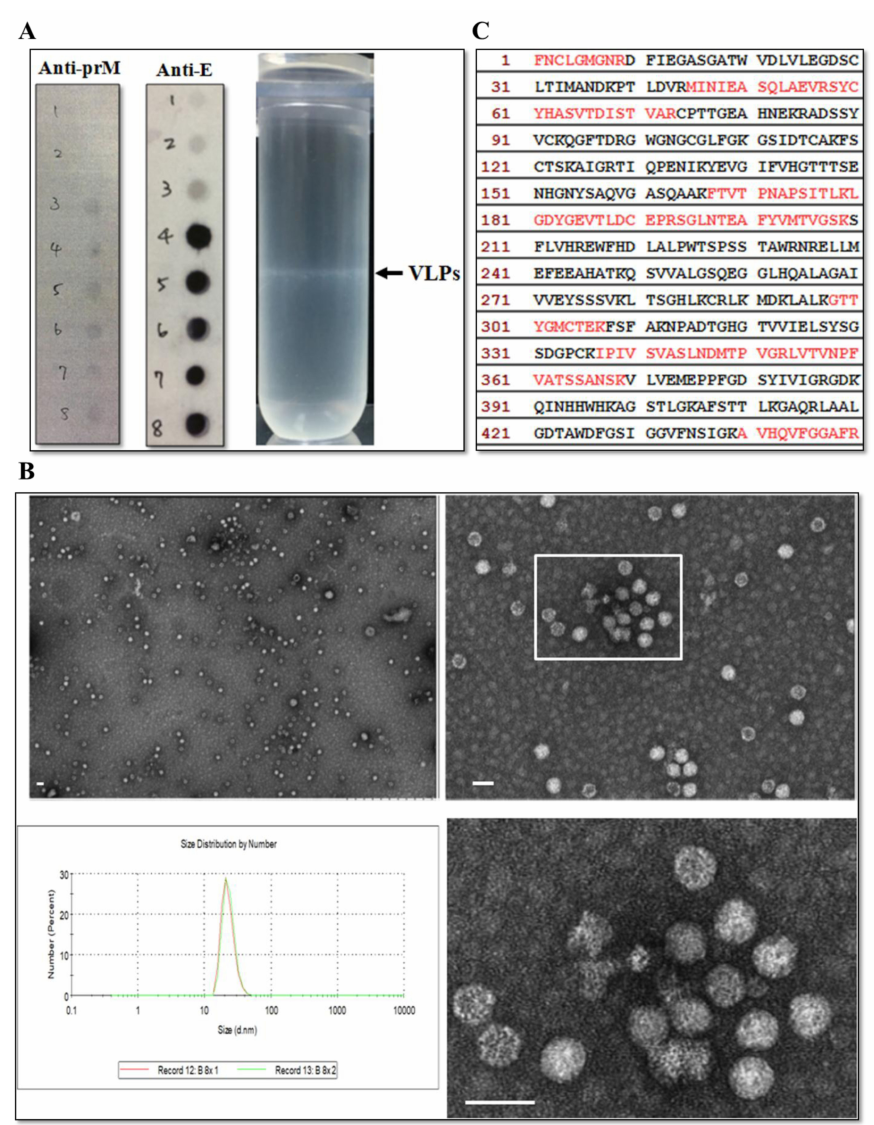
Figure 4. VLPs characterization. ( A ) Sucrose gradient banding JE VLPs. Representative photograph ( left panel ) of the sucrose density gradient following ultracentrifugation to isolate JEV VLPs. Arrow on the left indicates the VLP band. Fractions on the right from 1 ( top ) to 8 ( bottom ) were subjected to dot blot analysis ( right two panels ) using the indicated antibodies. ( B ) Electron micrographs and size distribution of JEV VLPs. Purified JEV VLPs were examined using transmission electron microscopy ( upper and lower right panels ). The boxed area in the upper right panel contains the same tissue section as that shown in the bottom panel. Scale bars = 50 µ m. The size distribution of JEV VLPs ( lower left panel ) was determined using DLS. ( C ) Identification of peptides from E proteins in VLPs. Partially purified VLPs from fraction 5 were resolved using SDS-PAGE, and the Coomassie blue-stained band corresponding to E proteins was analyzed using mass spectrometry. The amino acid sequences of JEV E glycoproteins are shown, with the matching peptides obtained from the LC–MS / MS analysis shown in